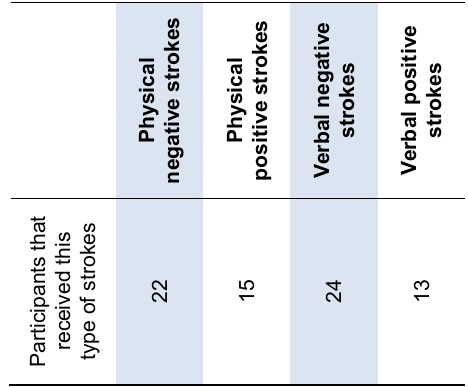
Table 8: Results of Brief Script